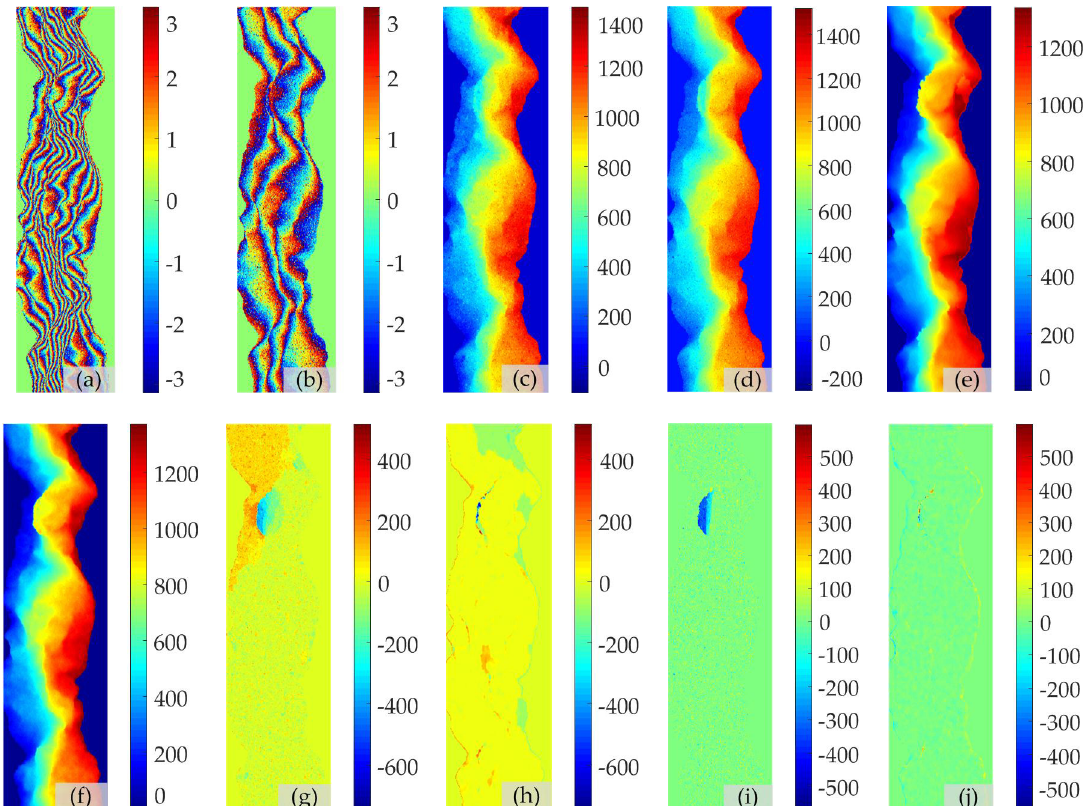
Figure 5. ( a ) Simulated interferogram with long normal baseline. ( b ) Simulated interferogram with short normal baseline. ( c ) Terrain height estimated result of (a) obtained by the two-stage programming approach (TSPA) method. ( d ) Terrain height estimated result of (b) obtained by the TSPA method. ( e ) Terrain height estimated result of (a) obtained by the TSPA–unscented Kalman filter phase unwrapping (UKFPU) method. ( f ) Terrain height estimated result of (b) obtained by the TSPA–UKFPU